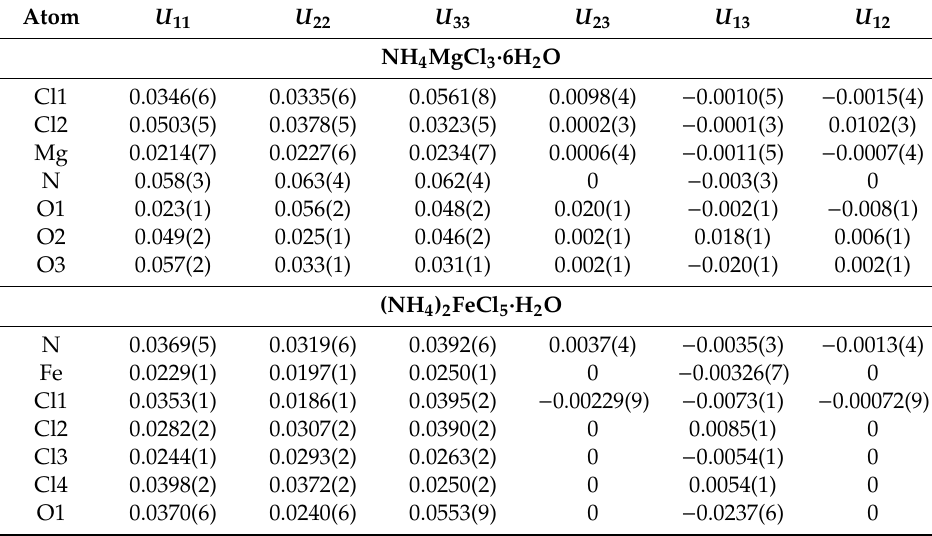
Table 6. Anisotropic displacement atom parameters (Å 2 ).